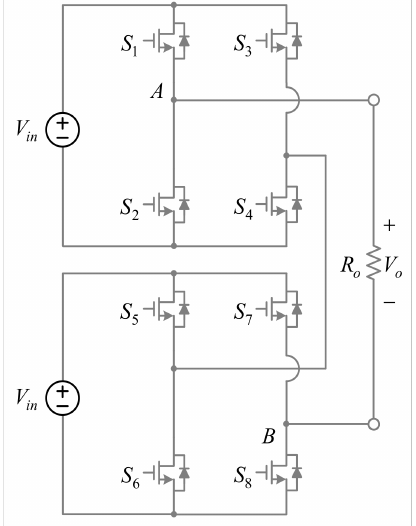
Figure 11. Zero voltage output of a five-level series-connected